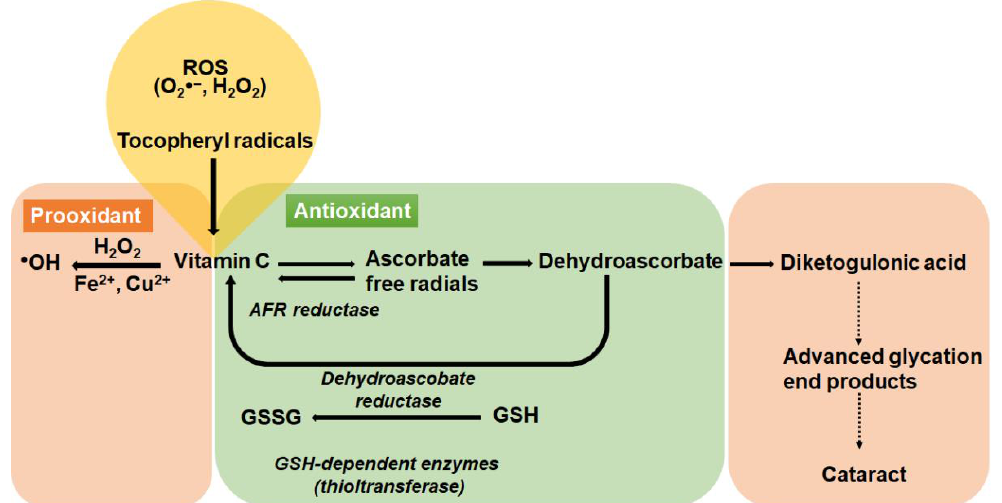
Figure 3. The redox pair vitamin C/DHA. The antioxidant vitamin C is oxidised first to the ascorbate radical and then to DHA which are both reversible reactions due to the enzymes AFR reductase and DHA reductase which relies on GSH as a co-factor. With continued oxidative stress, DHA undergoes an irreversible rearrangement to diketogulonic acid which is linked to accelerated protein cross linking and cataract formation. Vitamin C can also act as a pro-oxidant by reducing metal ions that generate free radicals through the Fenton reaction .